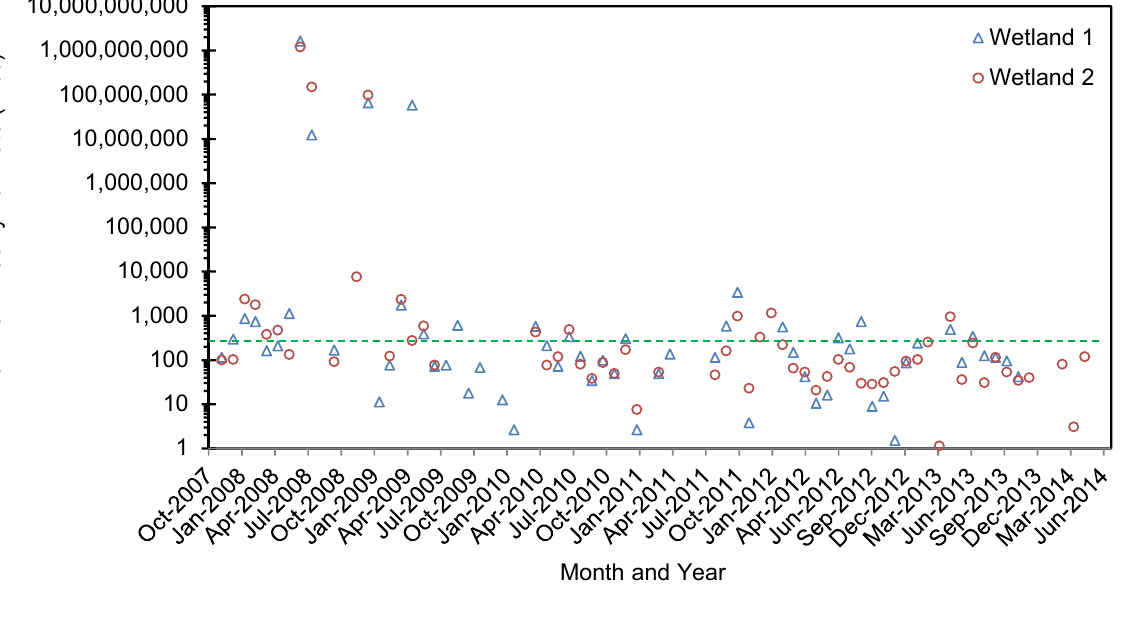
Figure 7. Event volume of CSO overflow from a grit removal unit to Harbor Brook constructed wetlands in an average year. Data source: CH2MHILL and CHA